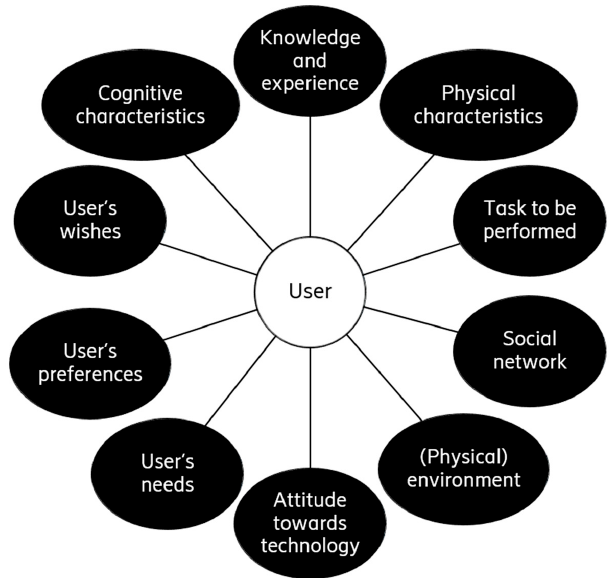
Figure 3. Parameters affecting the user interaction.